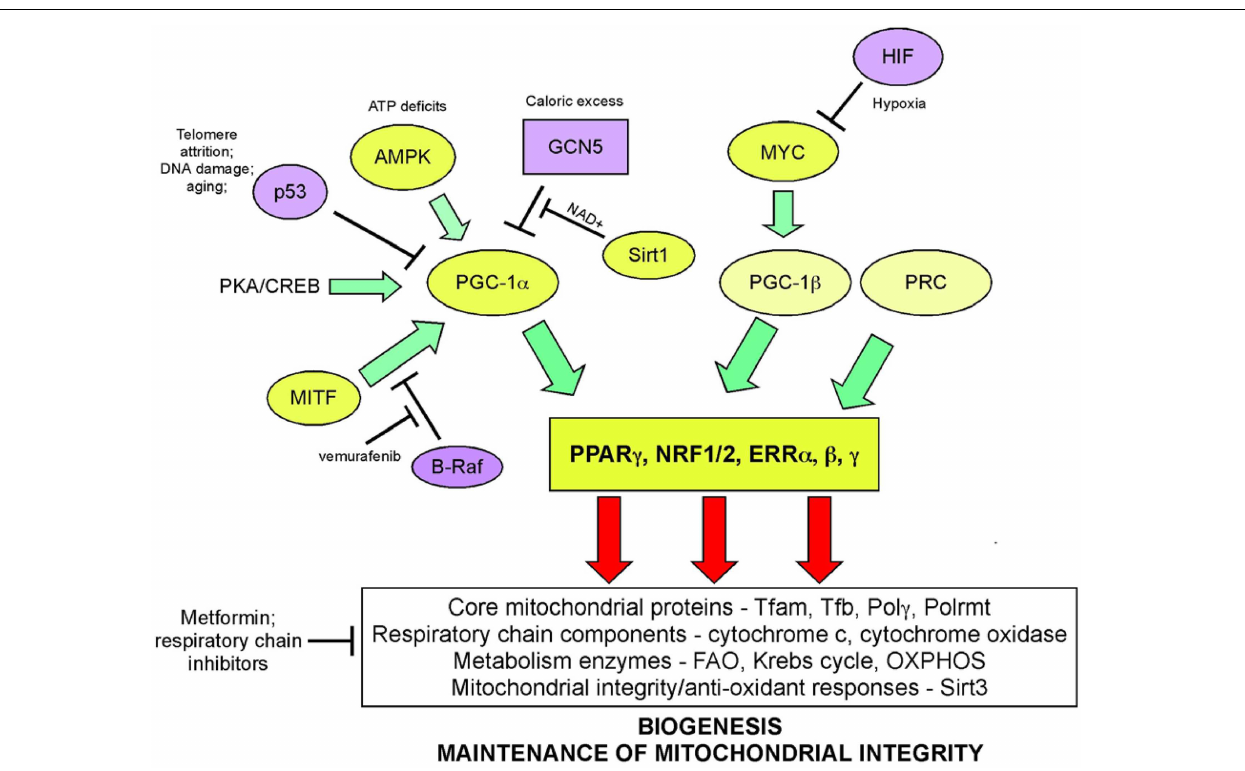
active at the mitochondria and other proteins that are imported into the mitochondria. Mitochondrial encoded proteins required for respiratory chain function are also induced secondary to the actions of PGC-1 α and its related proteins, PGC-1 β , and PRC. Both p53 (through inhibition of PGC-1 α ) and c-MYC (through activation of PGC-1 β ) modulate biogenesis. Recent data highlights a role for MITF-induced PGC-1 α activity and mitochondrial metabolism in a subset of human melanomas, that is sensitive to B-Raf inhibitors (since B-Raf blocks the action of MITF on PGC-1 α